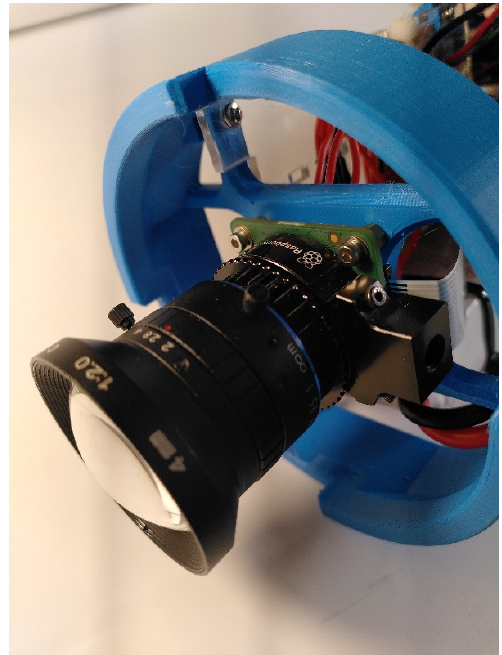
Figure 5. AICO lens with C-mount ring and Pi-Camera HQ 12MP secured on 3D-printed